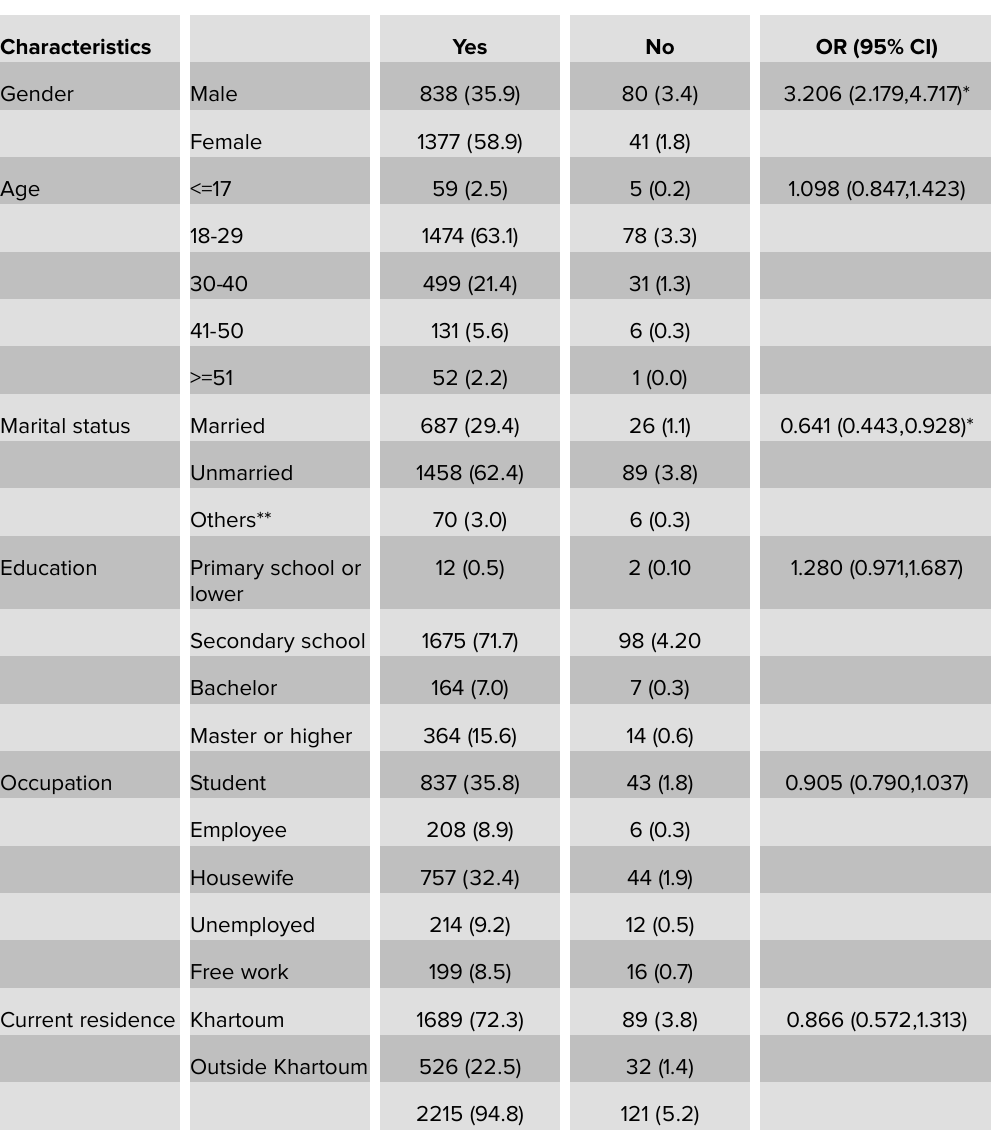
TABLE 5: Attitudes towards COVID-19 by demographic variables, (Are you ready to commit to the decision of staying at home?)